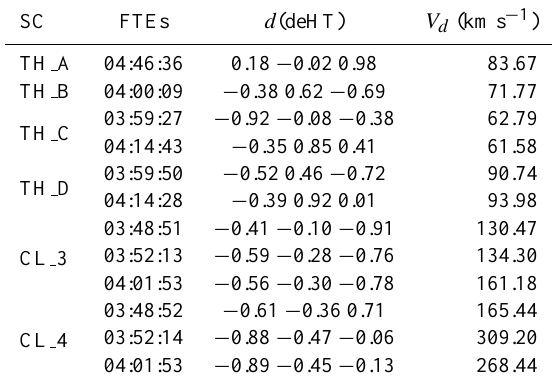
Table 1. The direction of motion ( d ) and speed ( V d ) of the FTE signatures, using de Hoffmann-Teller analysis, on Cluster and THEMIS where available, seen during the 14 June 2007 event. Here the IMF was initially in + B y , and turns into − B z (after 03:50), the solar wind ram pressure was steadily